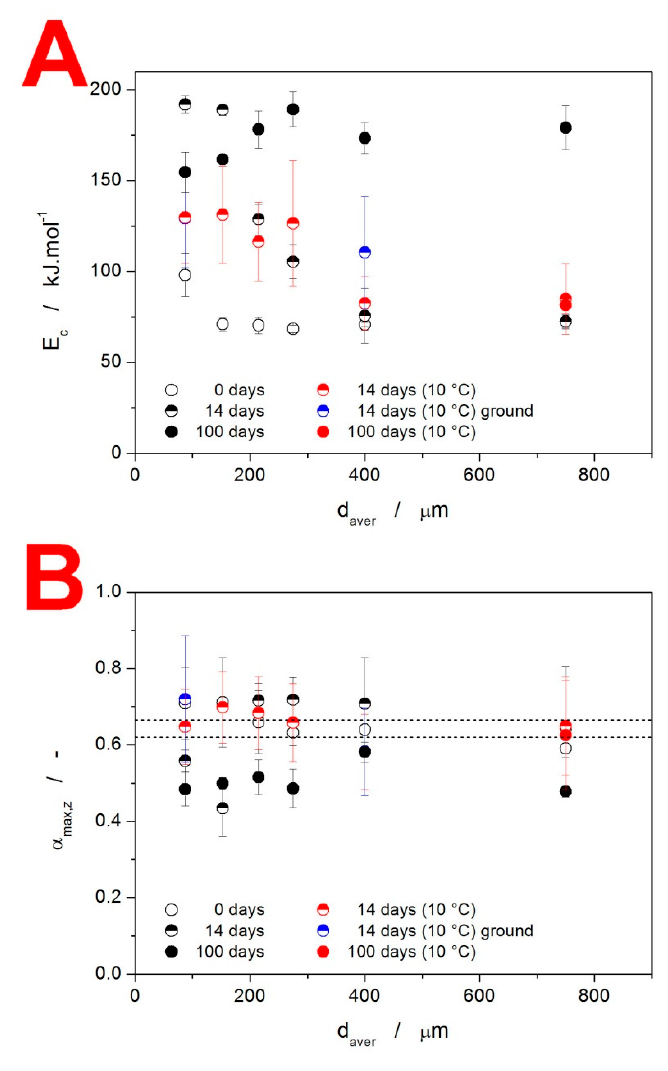
Figure 8. ( A ) Activation energy of the crystallization process E c determined using Equation (2) from the Kissinger dependencies displayed in Figure 7. ( B ) Values of the degree of conversion corresponding to the maxima of the characteristic kinetic functions z( α ), see Equation (3), determined for the IMC powders stored under various conditions. The dashed horizontal lines indicate the applicability range of the JMA kinetic model.